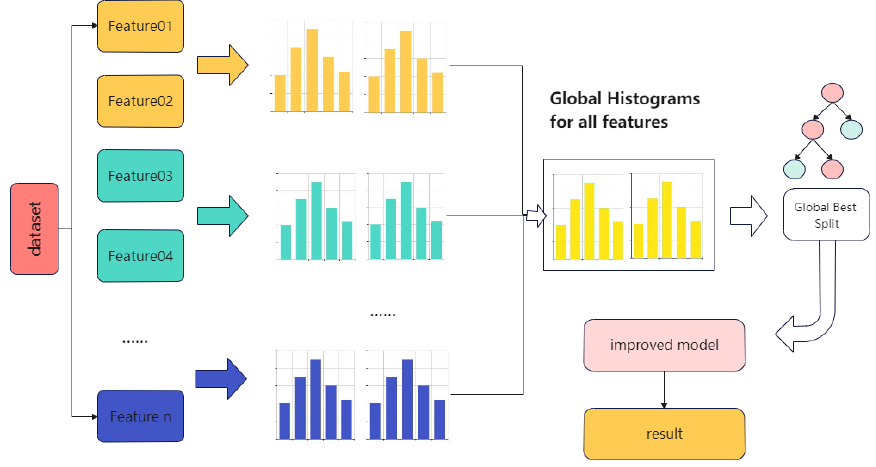
Figure 3. Diagram of LightGBM prediction flow.